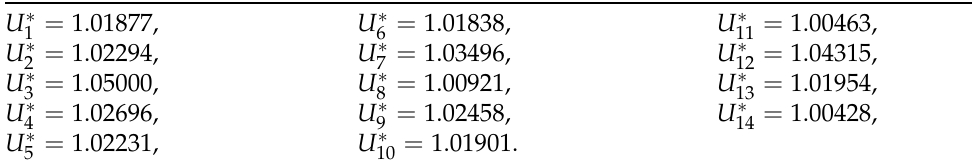
Table 6. Voltage level at the equilibrium for Example